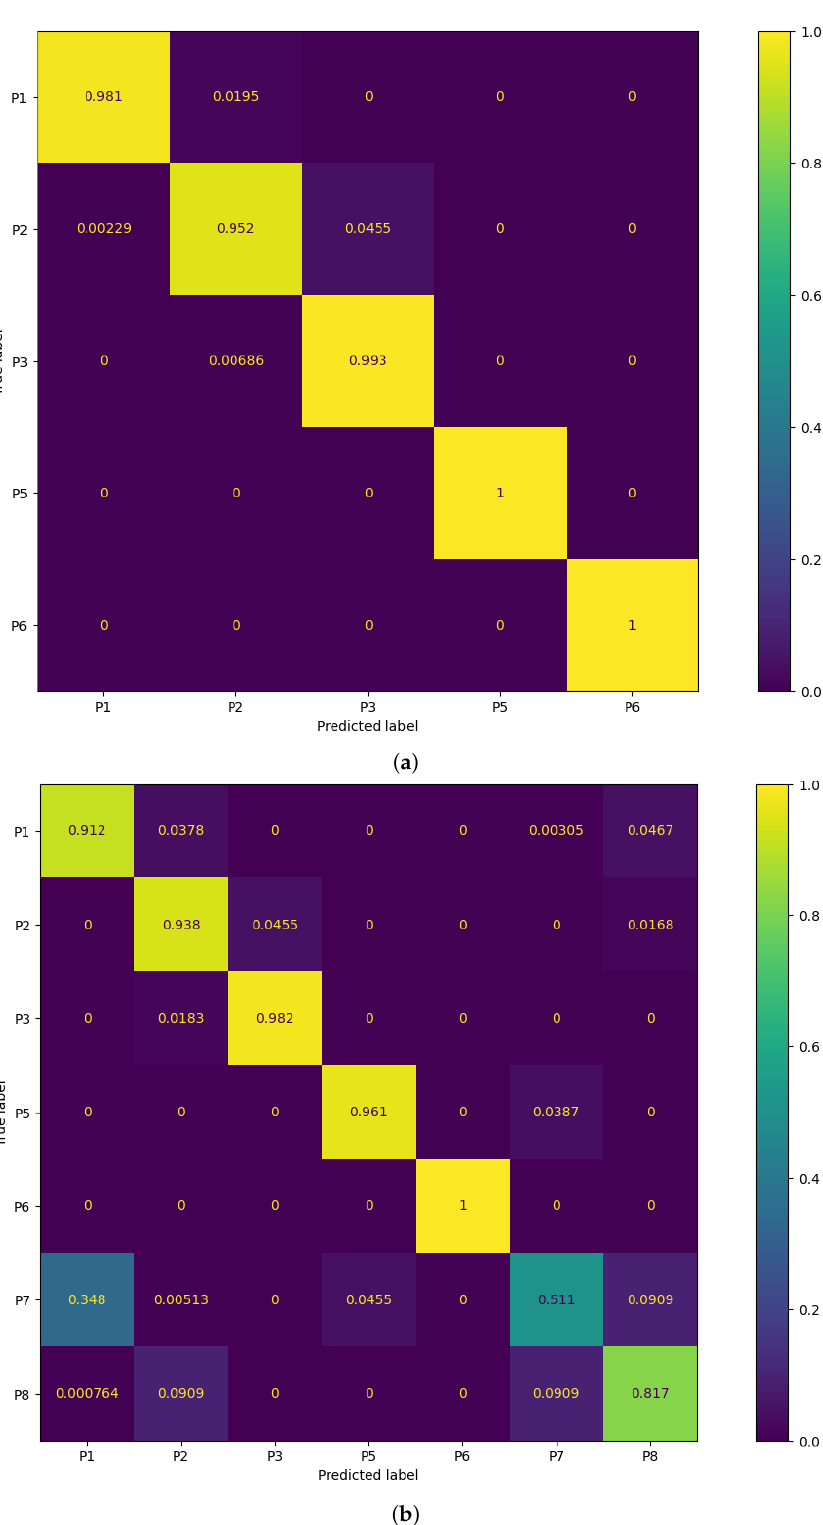
Figure 8. Confusion matrix of the best performing models: ( a ) 5-class k-NN using 1000 neighbors and ( b ) 7-class k-NN using 3000